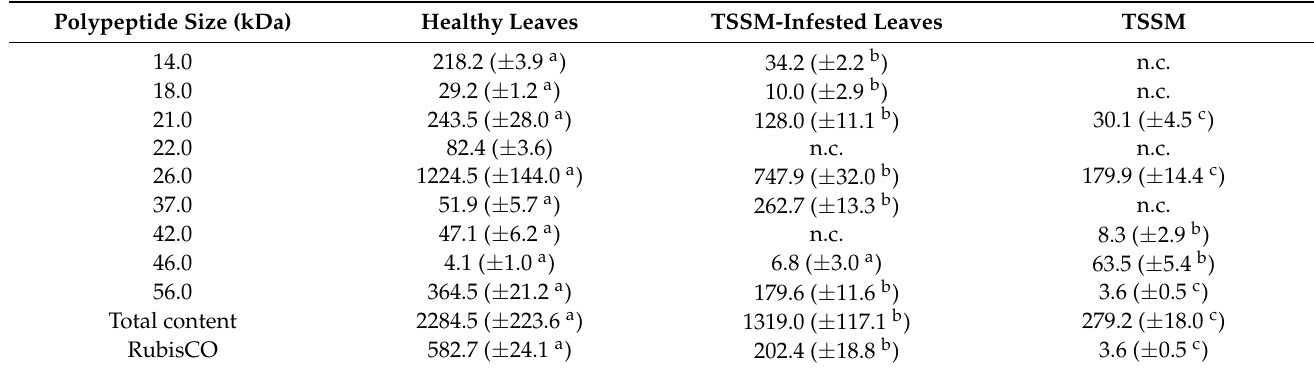
Table 3. The relative concentration of polypeptides was calculated from the capillary gel electrophore- sis of protein extracts from healthy and TSSM-infested Lima bean leaves and from TSSMs. Values are expressed as µ g ml − 1 ( ± standard deviation). In the same row, different letters indicate significant ( p < 0.05) differences; n.c., not